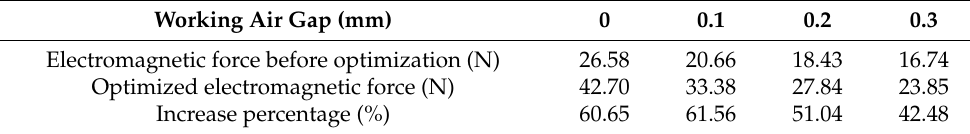
Table 7. Simulation results of static electromagnetic force before and after